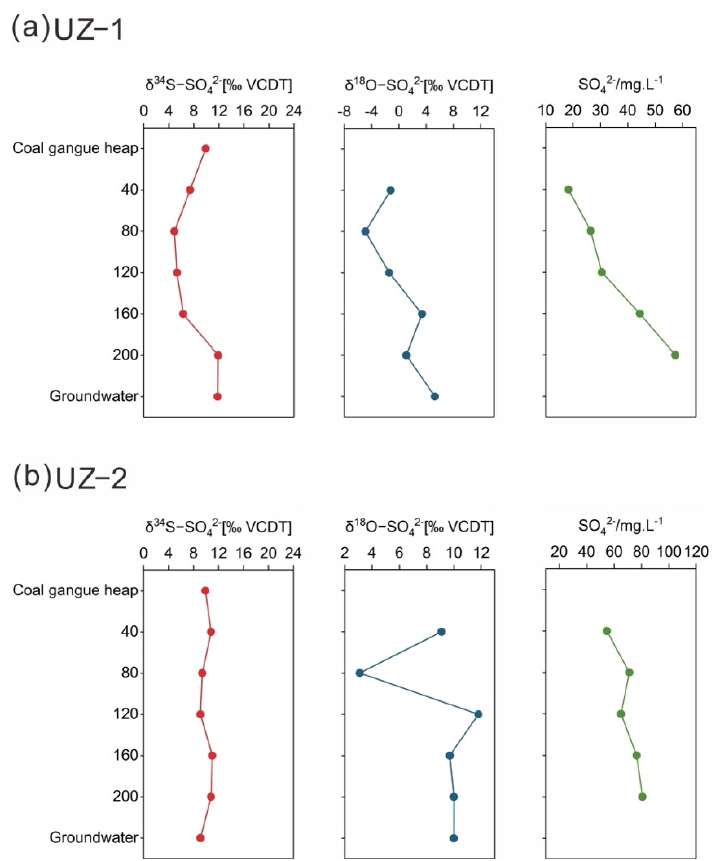
Figure 6. ( a ) The SO 42 − concentration and isotopic data of the water − soluble sulfates ( δ 34 S − SO 42 − and δ 18 O − SO 42 − ) for samples taken from coal gangue, soil profiles (UZ − 1) and groundwater (G1); ( b ) The SO 42 − concentration and isotopic data of the water − soluble sulfates ( δ 34 S − SO 42 − and δ 18 O − SO 42 − ) for samples taken from coal gangue, soil profiles (UZ − 2) and groundwater (G7).